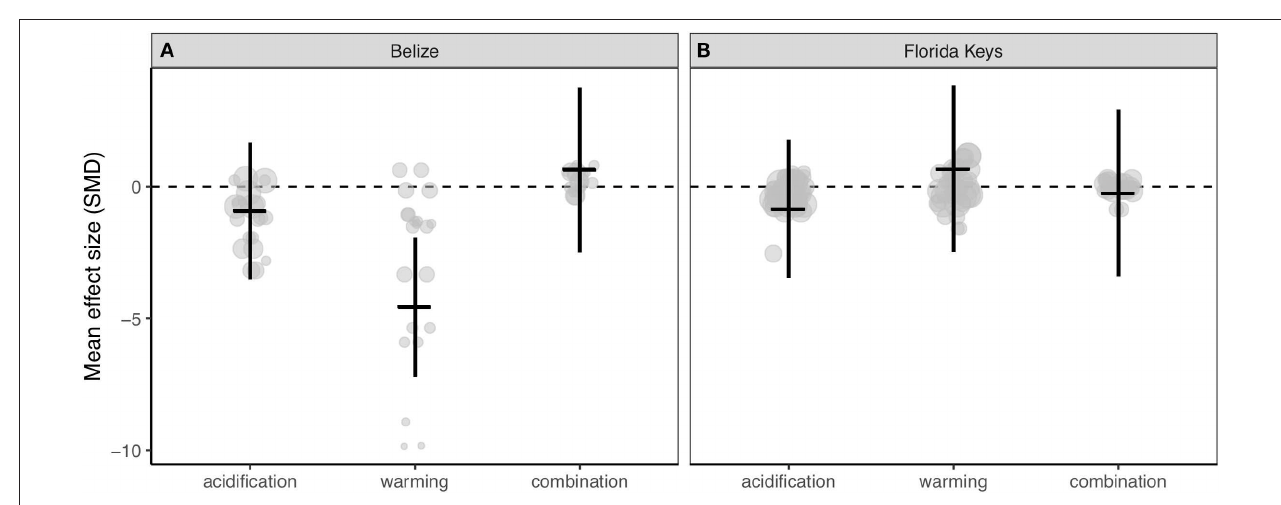
FIGURE 3 | Mean effect (standard mean difference) and 95% confidence interval of ocean acidification, warming, and the combination of acidification and warming on calcification rate for (A) Belize corals and (B) Florida Keys corals. Gray circles indicate the effect size of each individual study and the size of each circle represents the weight of each study (1/SE). Clear statistical evidence of a treatment effect is identified when the 95% confidence interval does not overlap zero.